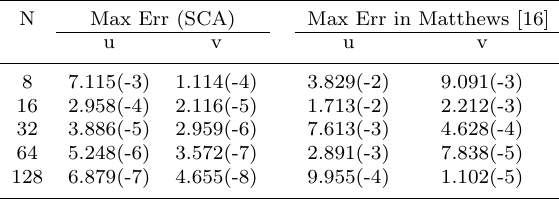
Table 4. Maximum Error of Example 4 for (cid:15) = 2 − 8 .